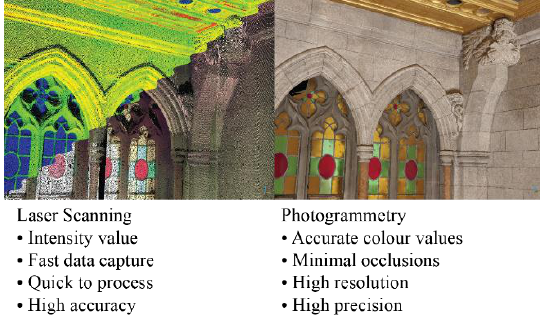
Figure 2: North-West corner of Senate Chamber illustrating benefits of laser scanning and photogrammetry. From right to left, intensity value point cloud from laser scanning, RGB point cloud from laser scanning, and textured mesh from photogrammetry (HCS,